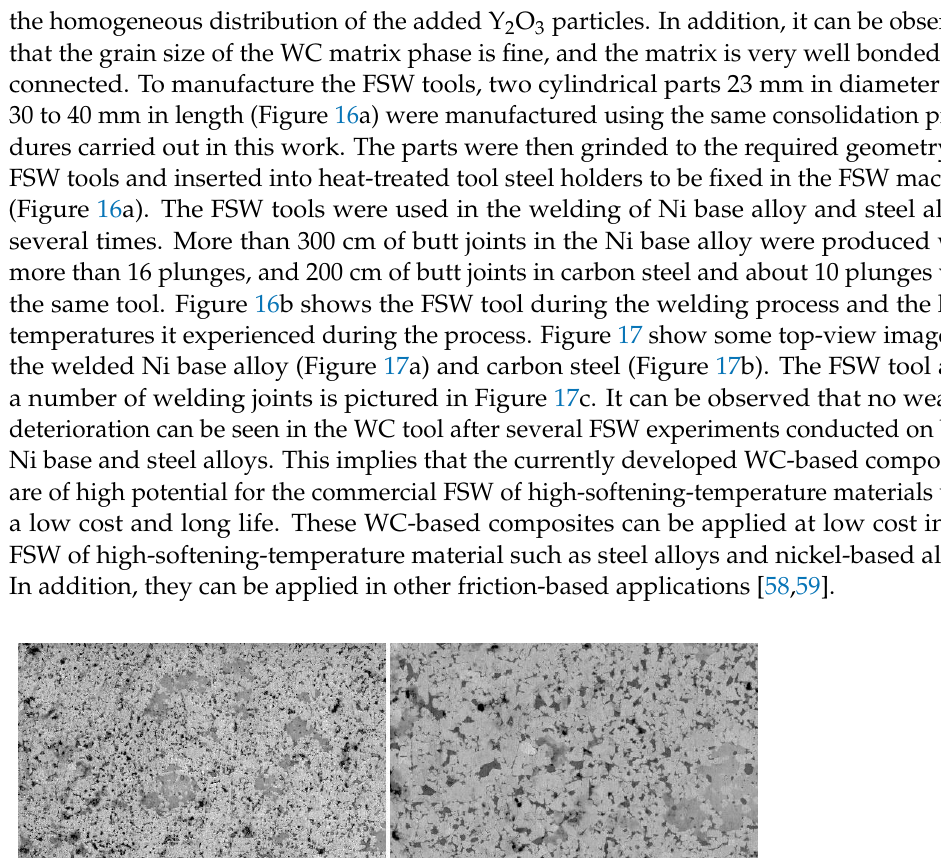
Figure 17. Top views of the welded materials using the produced WC-based composite tool mate- rial (WC-Co-TaC-NbC with 2.5 wt% Y 2 O 3 and 5 wt% Ni). ( a ) Ni base alloy, ( b ) carbon steel, ( c ) the FSW tool after several FSW experiments. 5. Conclusions Two series of WC-Co-TaC-NbC and WC-Co-TaC-NbC-5 wt% Ni composites with different additions of Y 2 O 3 from 0–10wt% were produced and characterized. Based on the obtained results, the following conclusions can be outlined: 1. The consolidation process applied to the WC-based composites resulted in a relative density of up to 97%, which was enhanced by the 5 wt% Ni addition. 2. Upon the sintering process, the Co 3 W 3 C  -phase was formed, and its formation was slightly reduced by the addition of 5 wt% Ni and 2.5 wt% Y 2 O 3 . 3. The microstructure of the consolidated composites consisted of a very well-connected WC matrix, with homogenous dispersion of the Y 2 O 3 particles at the lower Y 2 O 3 content (up to 5 wt%) which retarded the grain growth during sintering. 4. The addition of 5 wt% Ni significantly enhanced the fracture toughness (max. of 10.4 MPa √𝑚 ), the transverse rupture strength (max. of 758 Mpa) and the compressive strength (max. of 3013 MPa). On the other hand, only the hardness was slightly reduced for all Y 2 O 3 contents; for example, at 0 w% Y 2 O 3 , the hardness was reduced from 1425 MPa to 1398 MPa. 5. The WC-Co-TaC-NbC with 2.5 wt% Y 2 O 3 and 5 wt% Ni was selected to manufacture friction stir welding tools, which were successfully used for the FSW of Ni base alloy